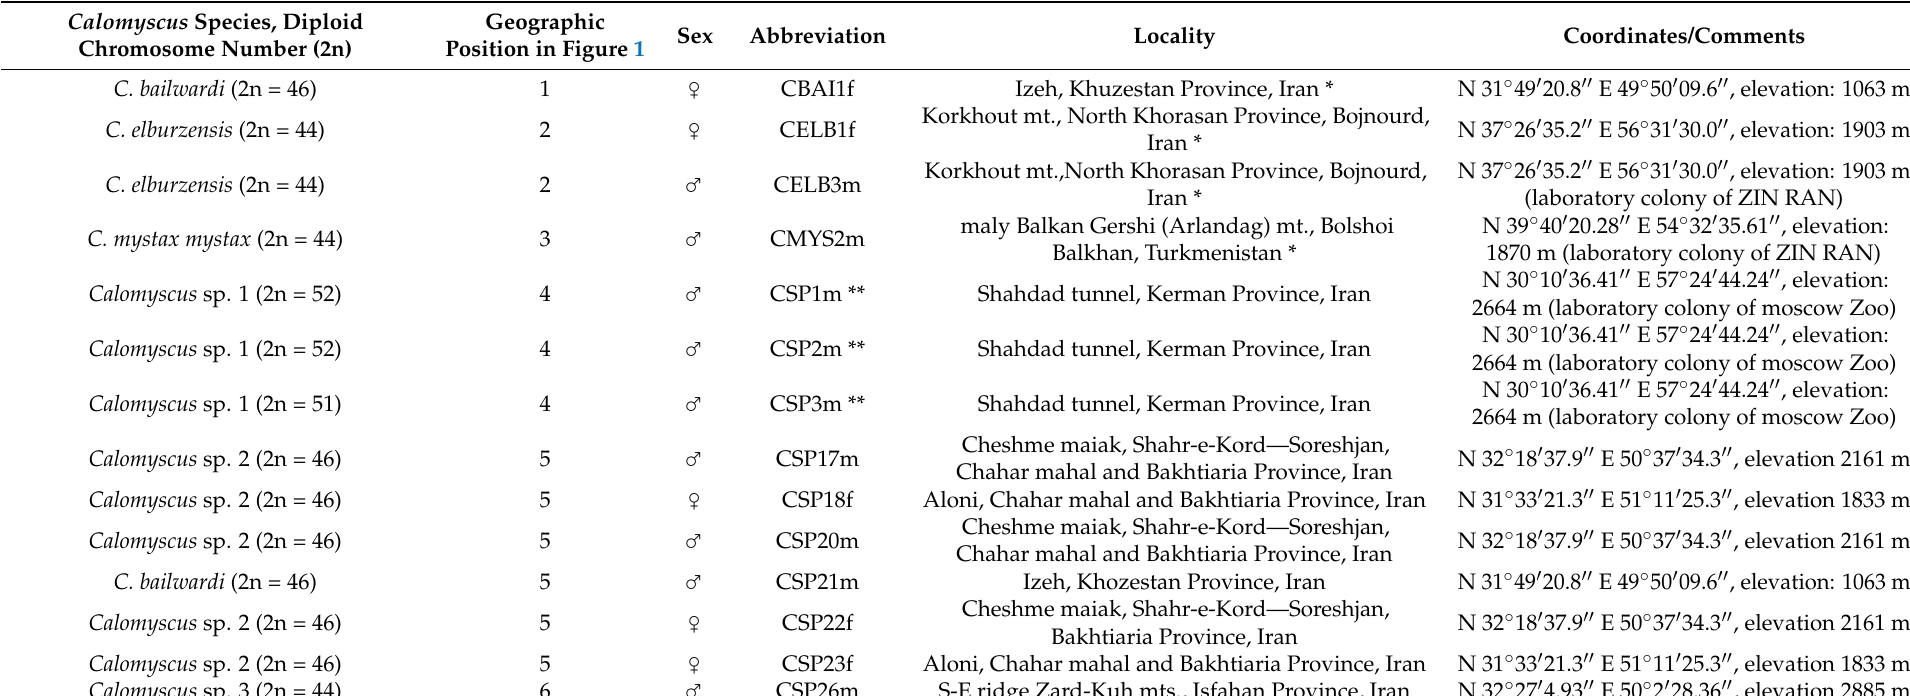
Table 1. Origins of the mouse-like hamsters examined in this